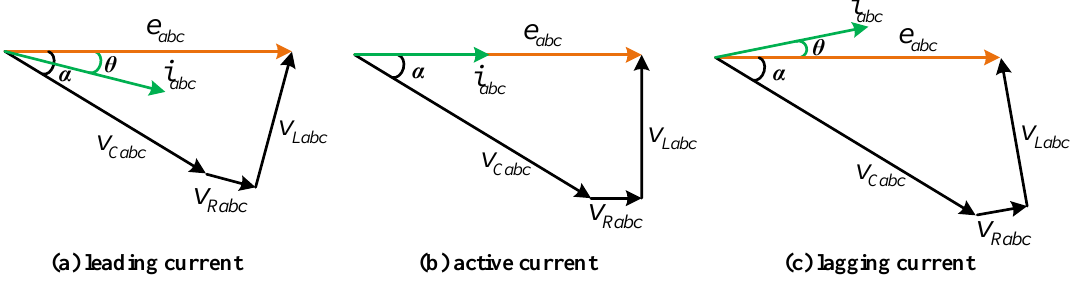
Figure 4. Phasor diagram of a 3-phase AC/DC PWM converter.